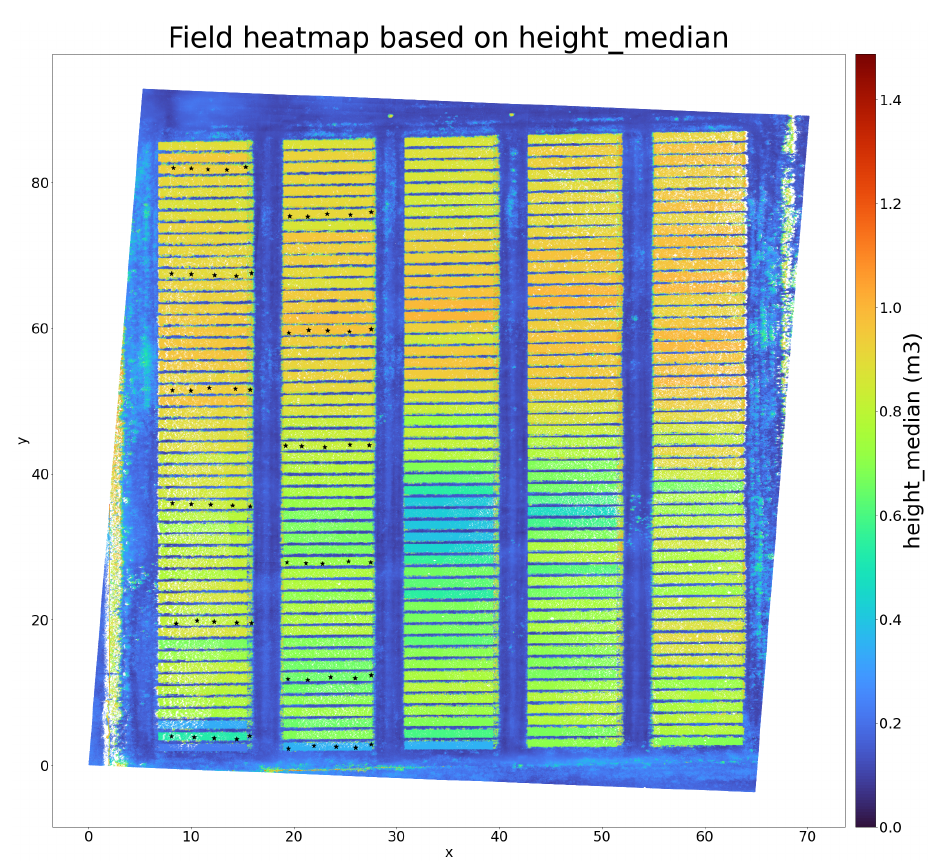
Figure 12. Heat-map visualization depicting canopy height value in an experimental area. Asterisks mark the points of manual